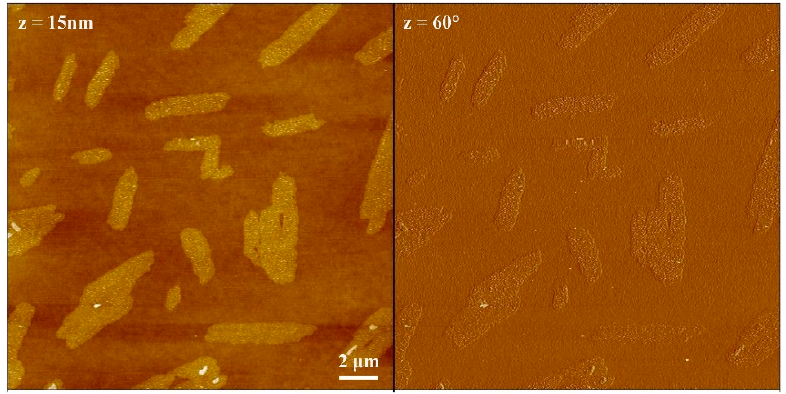
Figure 5. AFM topographies of StarP deposited on PHMS/Si: height image ( left ) and phase image ( right ).